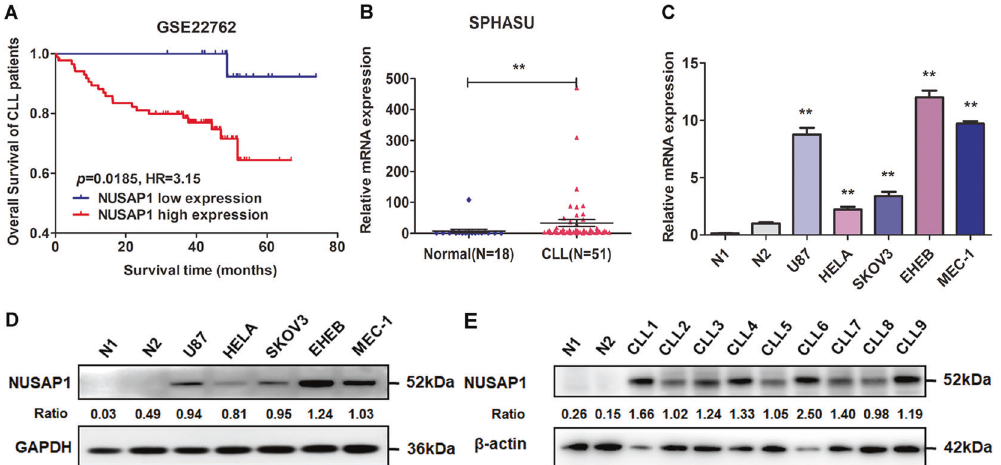
Fig. 1 NUSAP1 was elevated in CLL and related to prognosis of CLL patients. A Overall survival (OS) curves of CLL patients based on GSE22762 with strati fi ed NUSAP1 expression. B High mRNA expression of NUSAP1 was presented in CLL primary cells. C Excessive mRNA expression of NUSAP1 was detected in CLL cell lines (MEC-1, EHEB) than in both normal CD19 + B cells and other cancer cells by qRT-PCR. D High protein expression of NUSAP1 was observed in CLL cell lines. E High protein expression of NUSAP1 was observed in CLL patients than normal CD19 + B cells. Data are shown as the mean ± SD, n = 3. * p < 0.05; ** p <